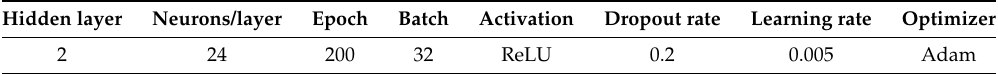
Figure 6. The architecture of a fully connected neural network. An input layer in red feeds explanatory variables and an output layer in green feeds response variable. Based on hyperparameter, the weight matrix (parameter) is built. Table 2. Hyperparameter of MLP (80%—training dataset, 20%—test dataset, shuffled method, 5 min. sampling interval